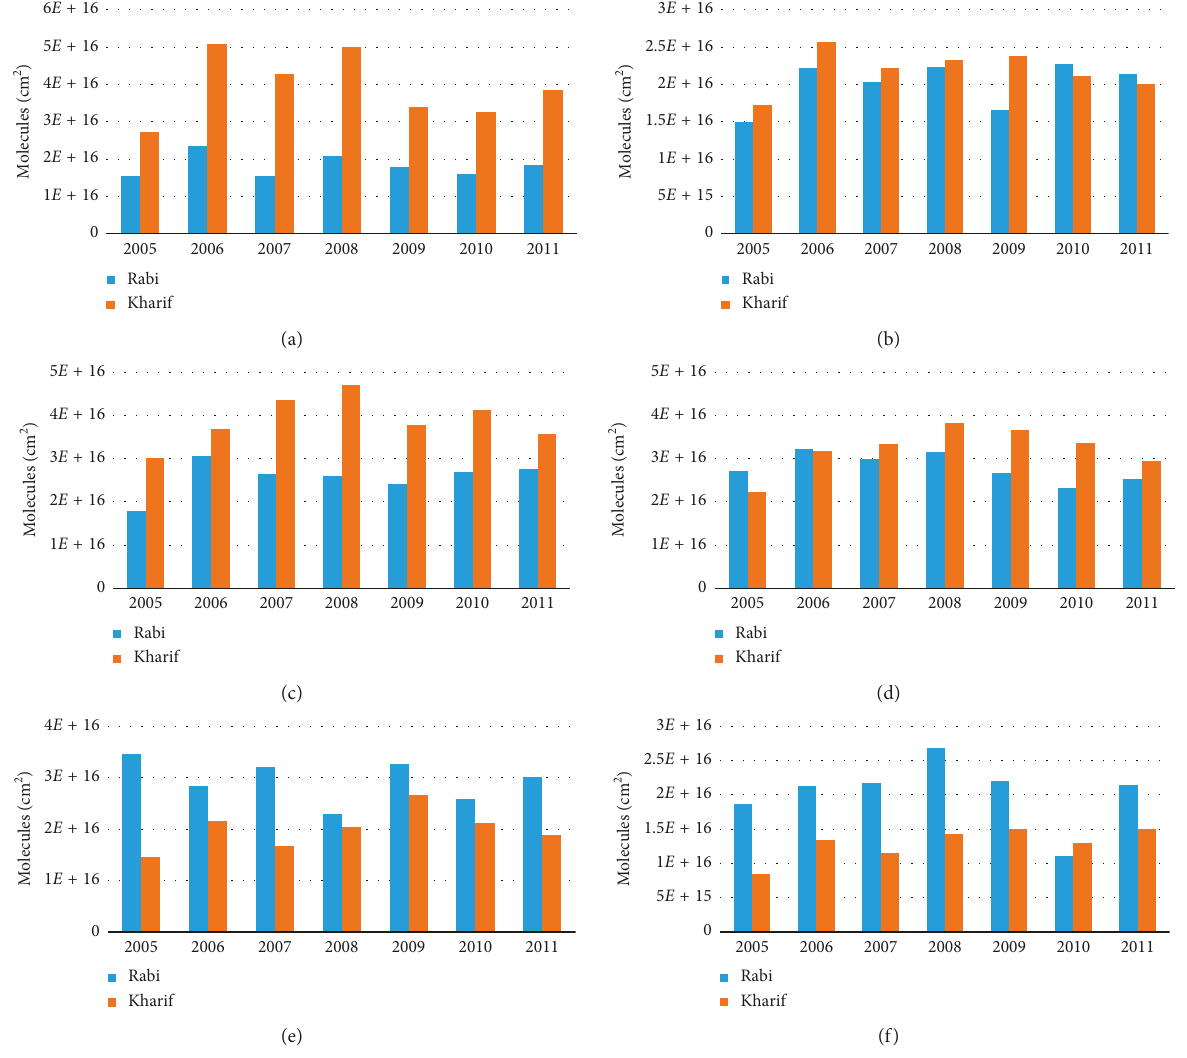
Figure 6: Rabi versus Kharif columns (molecules/cm 2 ) for the IGP regions plotted side by side shows that Kharif emissions are generally higher compared to Rabi emissions for the first four regions and are lower in case of IGP-4 and IGP-5. (a) IGP-1A. (b) IGP-1B. (c) IGP-2. (d) IGP-3. (e) IGP-4. (f) IGP-5. Rabi (Figure 8(b)) seasons in the IGP. It is evident from activities (no/low agriculture: pink; areas with medium Figure 8 that subregions 4 and 5 host very low agriculture agriculture: yellow; areas with extensive agriculture: green) activities during Kharif season as compared to other regions within the study region for both Kharif (Figure 8(a)) and